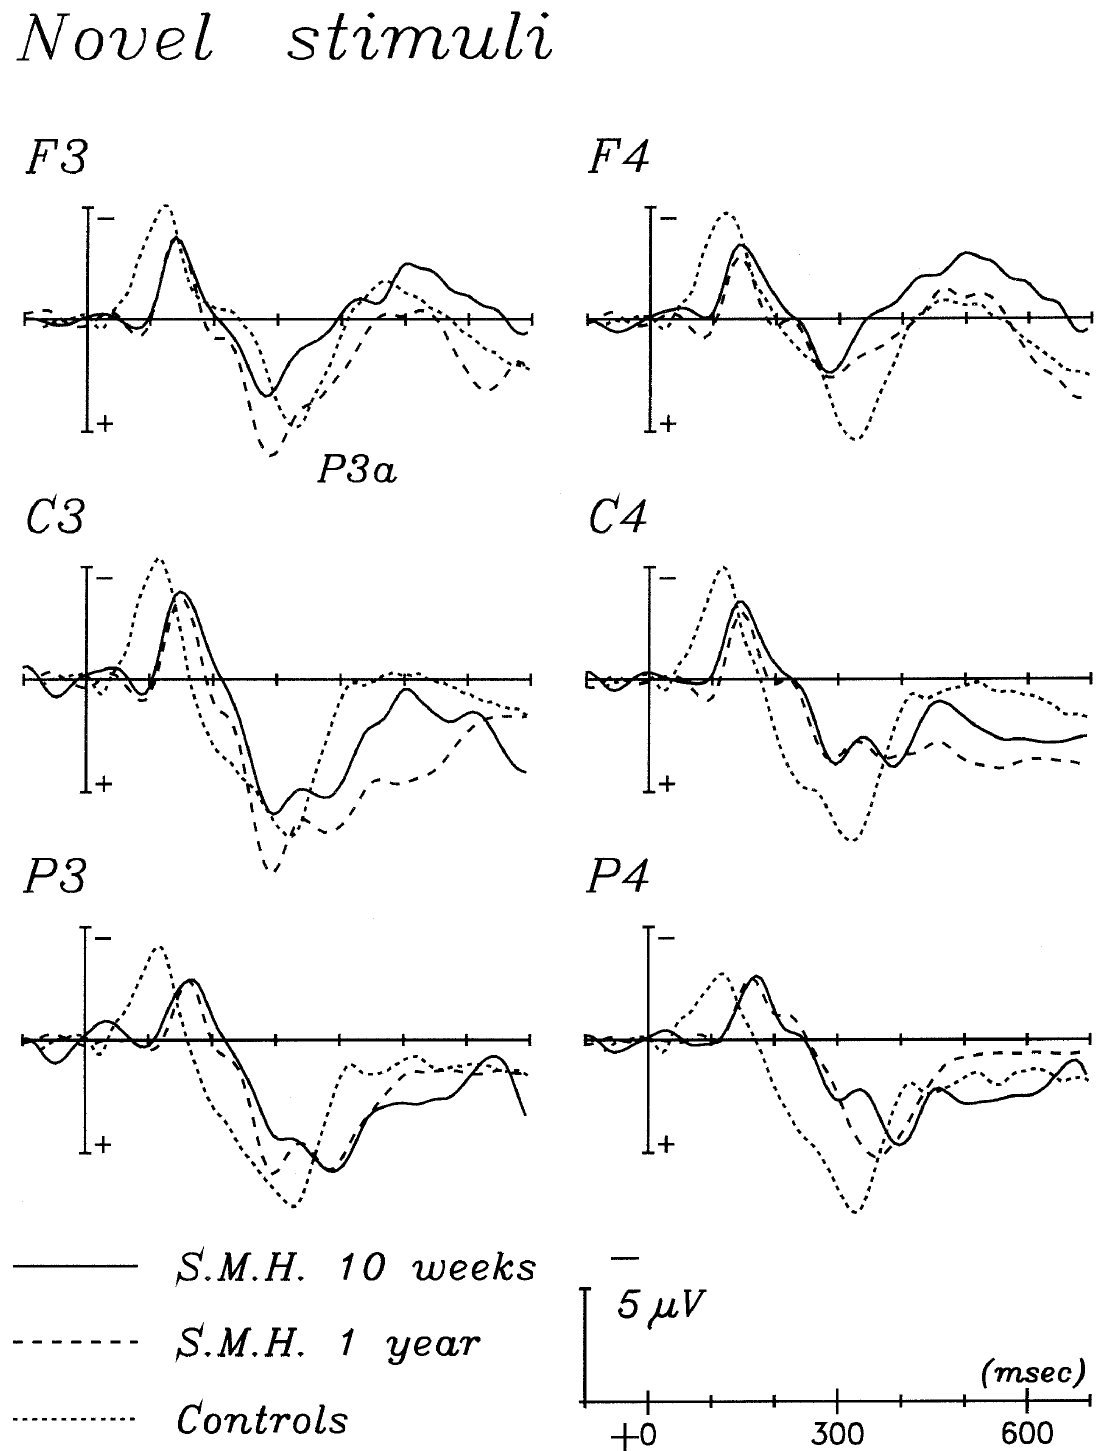
Fig. 5. Auditory event-related P3a-potentials to novels. The patient’s P3a is slightly reduced at the frontal and central electrodes of the right